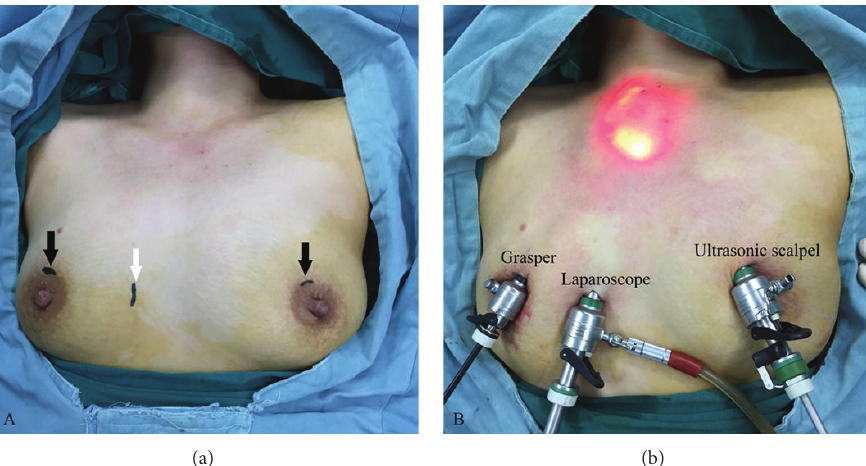
Figure 1: (a) Two incisions for the main and auxiliary operation ports (black arrow); the incision for laparoscope (white arrow); (b) external view after positioning the